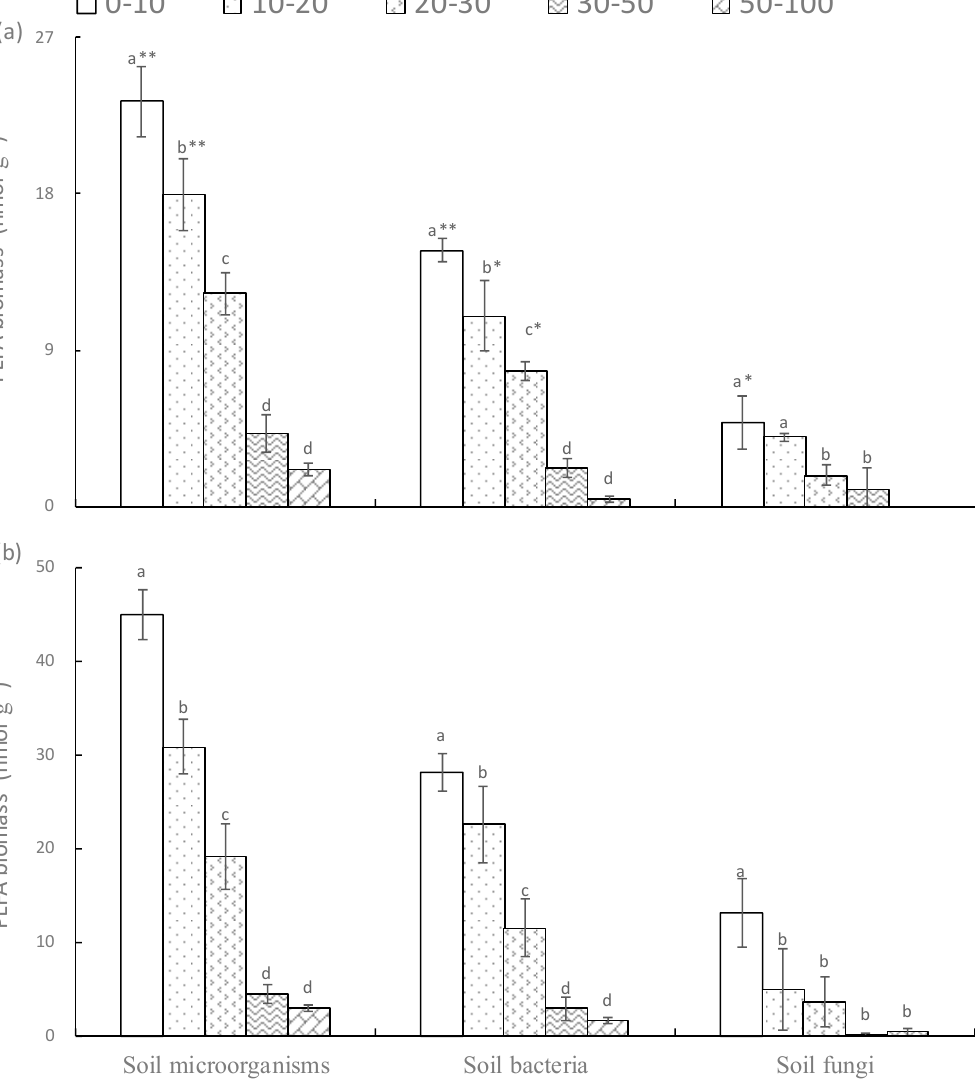
Figure 3. The soil microbial biomass in Haplic luvisols ( a ) and Eutric cambisols ( b ). PLFA means phosphor lipid fatty acid.